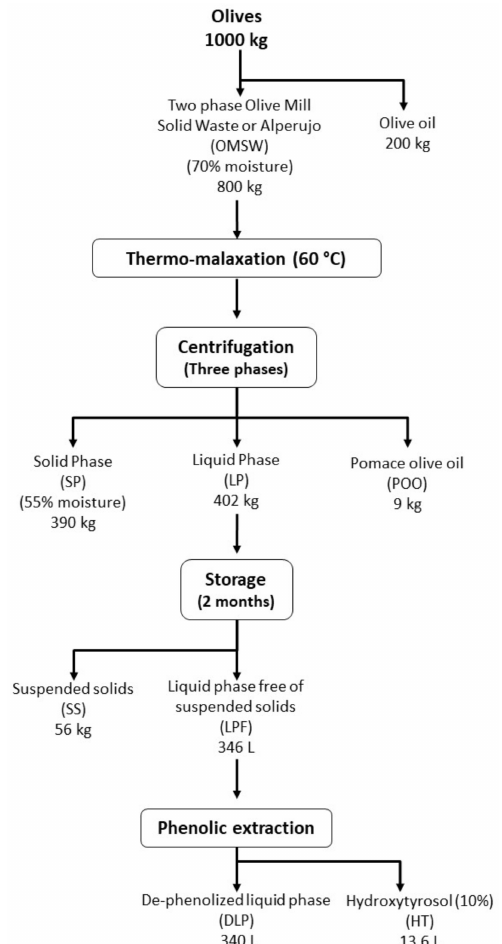
Figure 2. Process scheme (developed by the